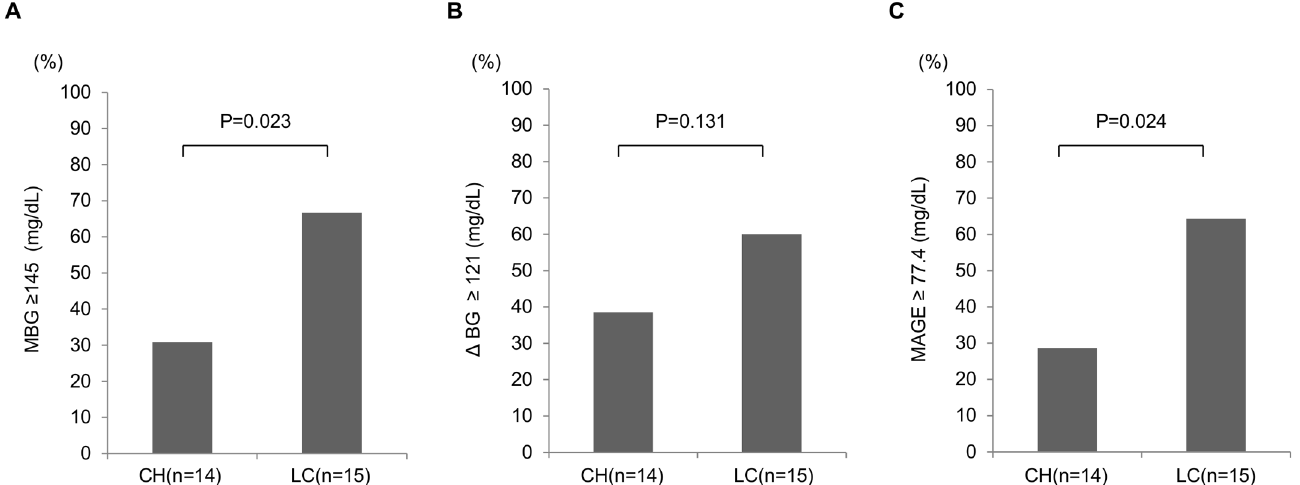
Fig 3. Comparison of CGM parameters between CH group and LC group among non-anemic patients with HbA1c levels of < 7.0%. (A) MBG, (B) Δ BG, and (C) MAGE. The population of patients whose values were more than or equal to the cutoff values were compared between CH patients and LC patients. MBG: mean blood glucose, Δ BG: the difference between the highest blood glucose and the lowest blood glucose, MAGE: mean amplitude of glycemic excursion, CH: chronic hepatitis, LC: liver cirrhosis.